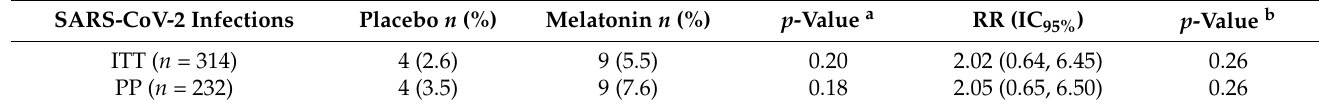
Table 2. Main efficacy outcome.